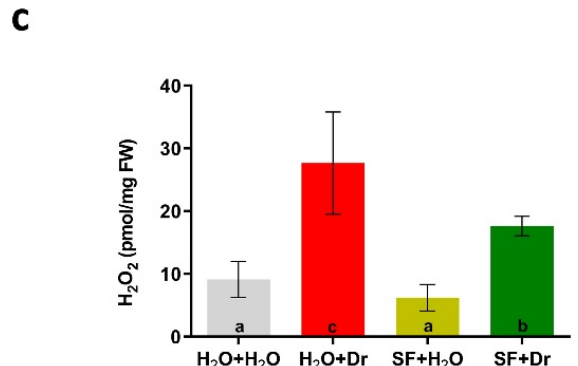
Figure 2. SF priming triggers a reduction in reactive oxygen species (ROS) levels. ( a ) Histochemical staining of ROS in leaves using 3,3 (cid:48) -diaminobenzidine (DAB). ( b ) Hydrogen peroxide levels in leaves of 15-day-old Arabidopsis Col-0 plants without (H 2 O+H 2 O) and with SF treatment (SF+H 2 O) in the absence of drought stress. ( c ) Hydrogen peroxide levels in leaves at 42 DAG. Note the higher H 2 O 2 levels in unprimed plants (H 2 O+Dr) compared to SF-primed plants (SF+Dr) under drought stress. Quantification of H 2 O 2 levels ( b , c ) was performed using the Amplex Red Hydrogen Peroxide/Peroxidase kit as reported [30]. Error bars in ( b , c ) denote the standard deviation of the mean (SD). In ( b ), asterisks (**) indicate significant difference ( n = 4) ( p < 0.01, Student’s t -test). In ( c ), different letters indicate statistically significant differences between the samples ( p < 0.05, n = 8; one-way ANOVA, Tukey’s multiple comparison test). FW, fresh weight; Dr, drought stress; SF, Super